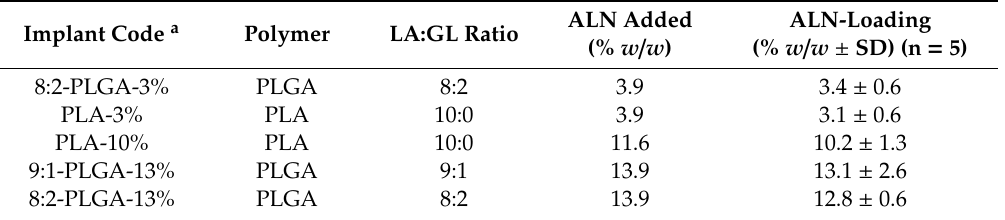
Table 2. Summary of investigated ALN-loaded implant formulations and their average ALN-loadings determined from total drug